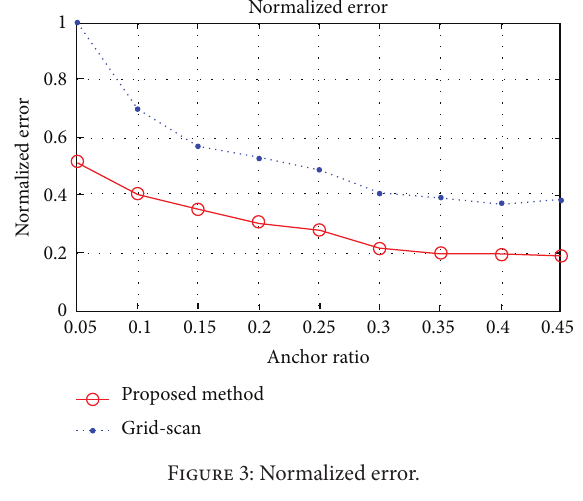
Figure 3: Normalized error.